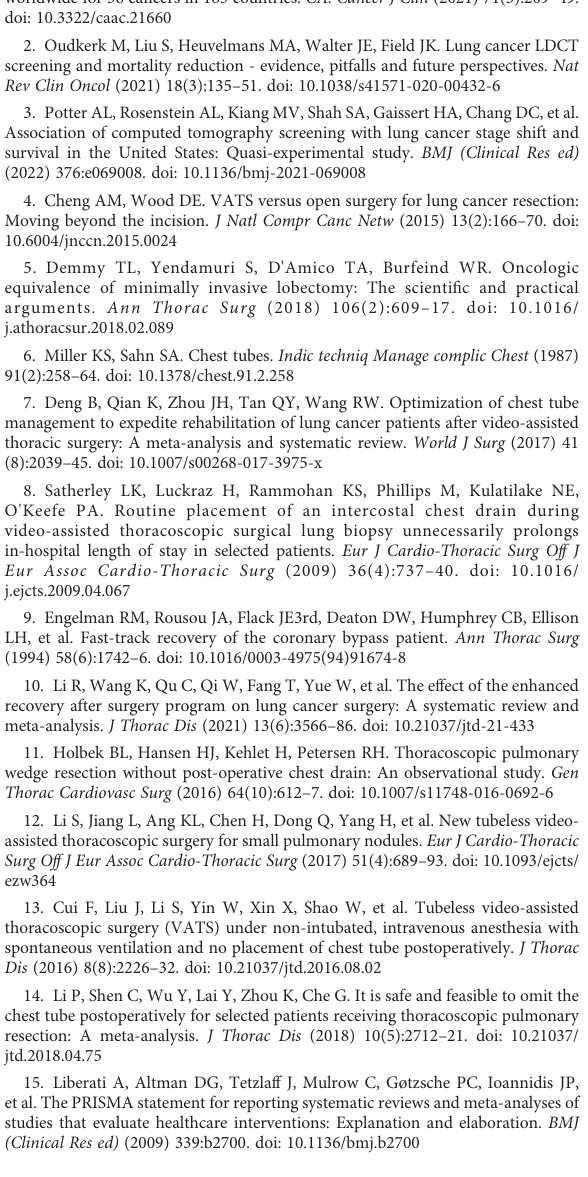
SUPPLEMENTARY FIGURE 1 Detailed quality assessment of included RCTs. (A) Risk of bias summary; (B) Risk of bias graph.